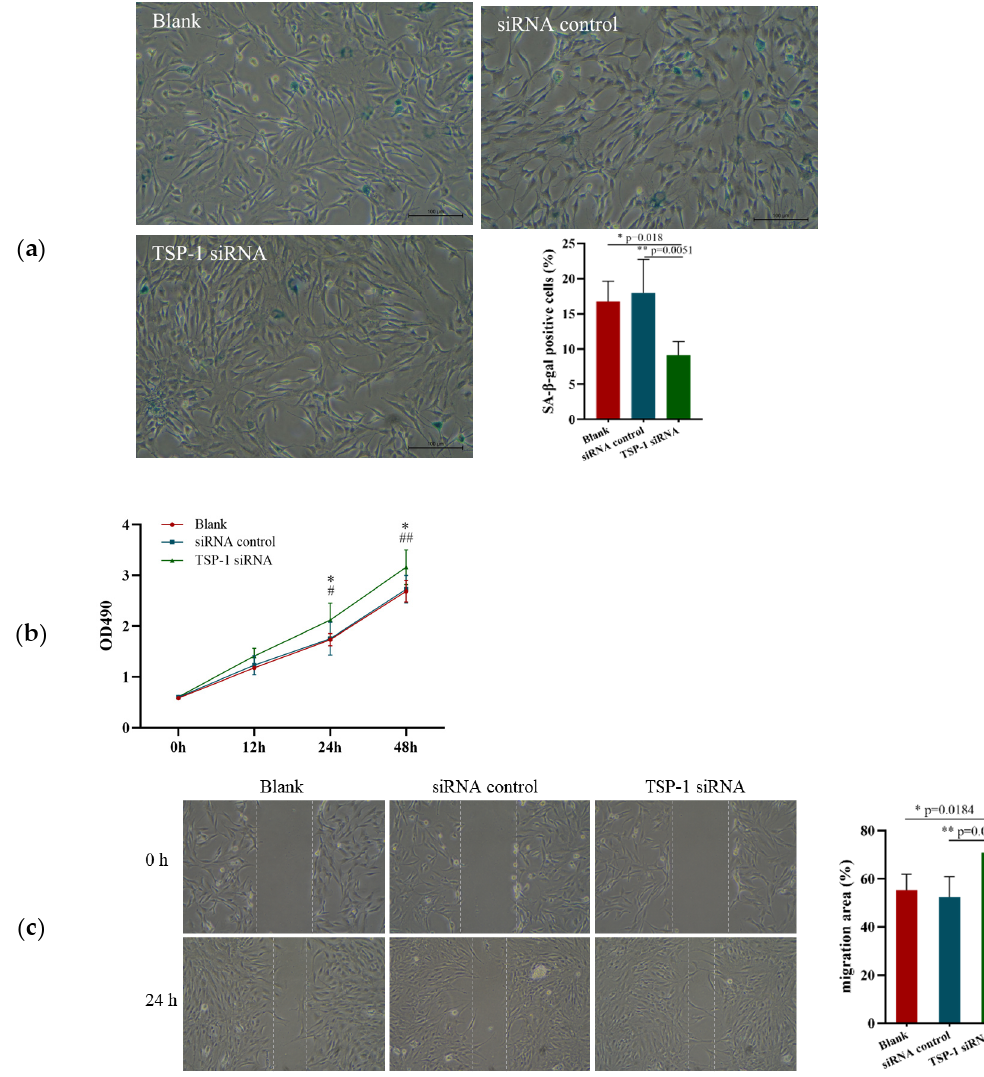
Figure 4. Effects of TSP-1 expression on EPCs function. ( a ) Cell senescence rate after transfection with TSP-1 siRNA for 24 h. ( b ) Proliferation of EPCs after transfection. ( c ). Migration function of EPCs after transfection. # p < 0.05, ## p < 0.01, * p < 0.05, ** p < 0.01. Bar, 100 μ m.